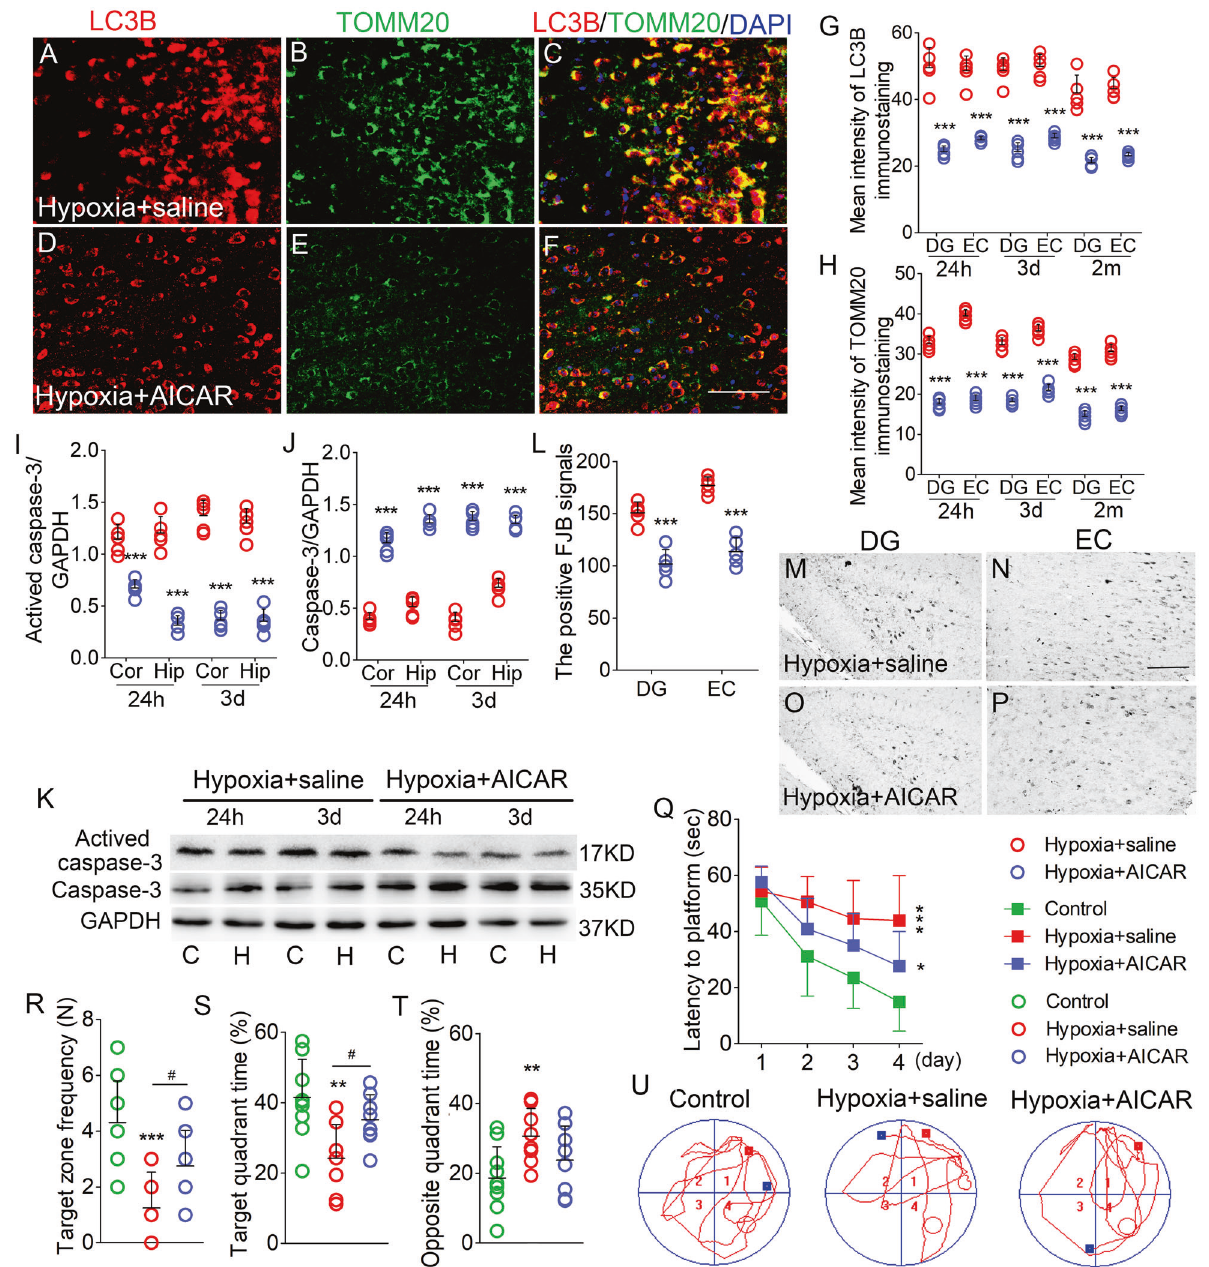
Fig. 8 AICAR reversed the increased mitophagy level, neuronal injury, learning and memory de fi cits induced by hypoxia treatment. A – F Decreased immunoreactivity of LC3B (red) and TOMM20 (green) in the EC region after AICAR treatment. Blue, DAPI. G , H Quanti fi cation of LC3B and TOMM20 fl uorescence intensity in DG and EC. I – K The expression of activated caspase-3 and caspase-3 in hippocampus and cortex detected by western blotting. L – P Positive FJB signals in DG and EC in each group. Bar = 50 μ m, n = 5/group. Q Latency to the platform (Two- way ANOVA). R Frequency of platform crossing. S Target quadrant time (%). T Opposite quadrant time (%). U Representative tracking. * P < 0.05, ** P < 0.01, and *** P < 0.001, all compared with controls (One-way ANOVA). # P < 0.05, compared with that in the hypoxia + saline group (One- way ANOVA with Dunnett ’ s T3 post-hoc